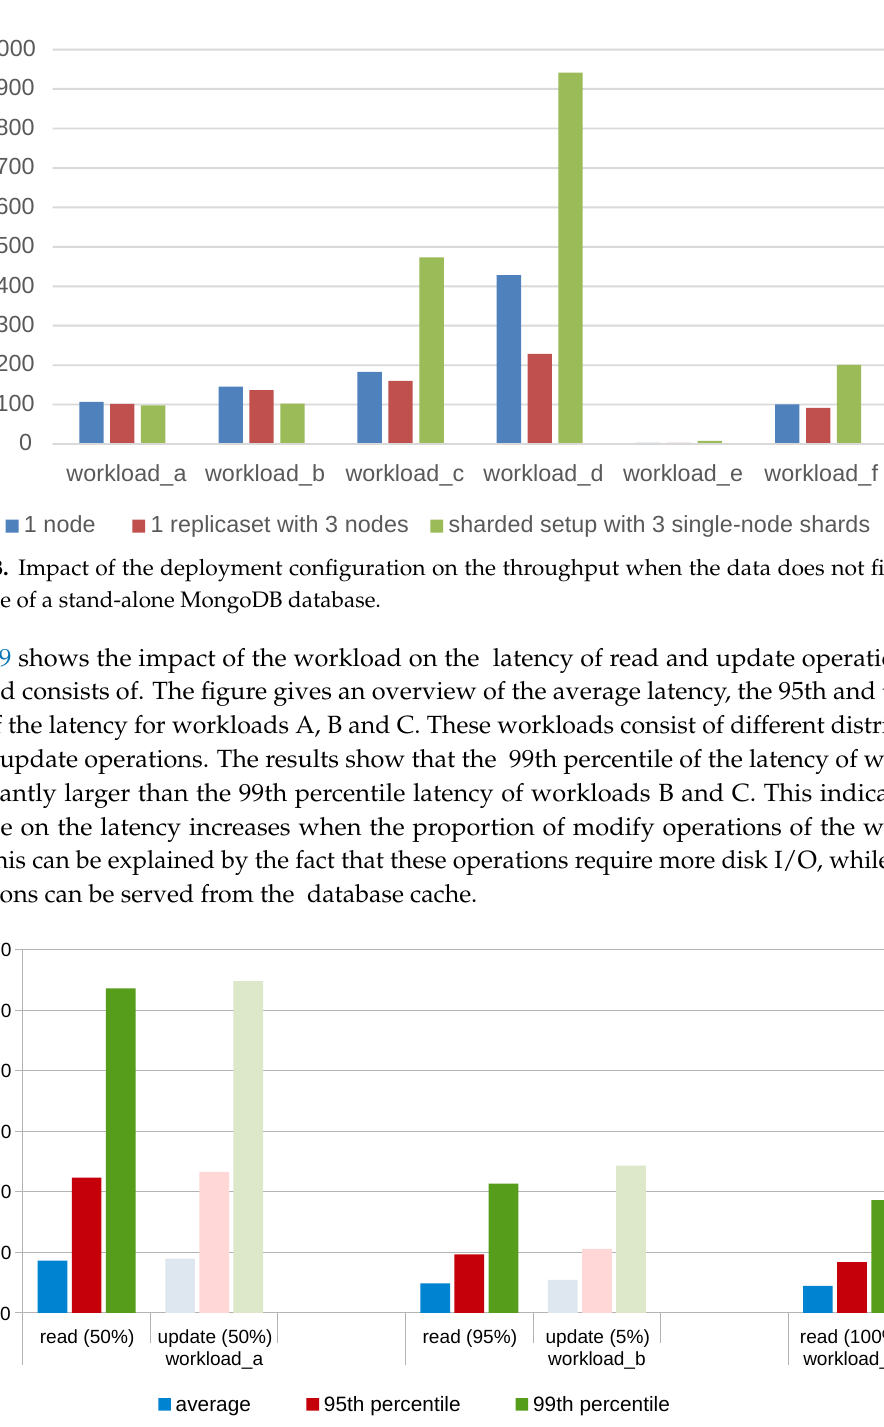
Figure 9. Impact of read/update mix on operation latency in a stand-alone MongoDB server deployed on an OptiPlex